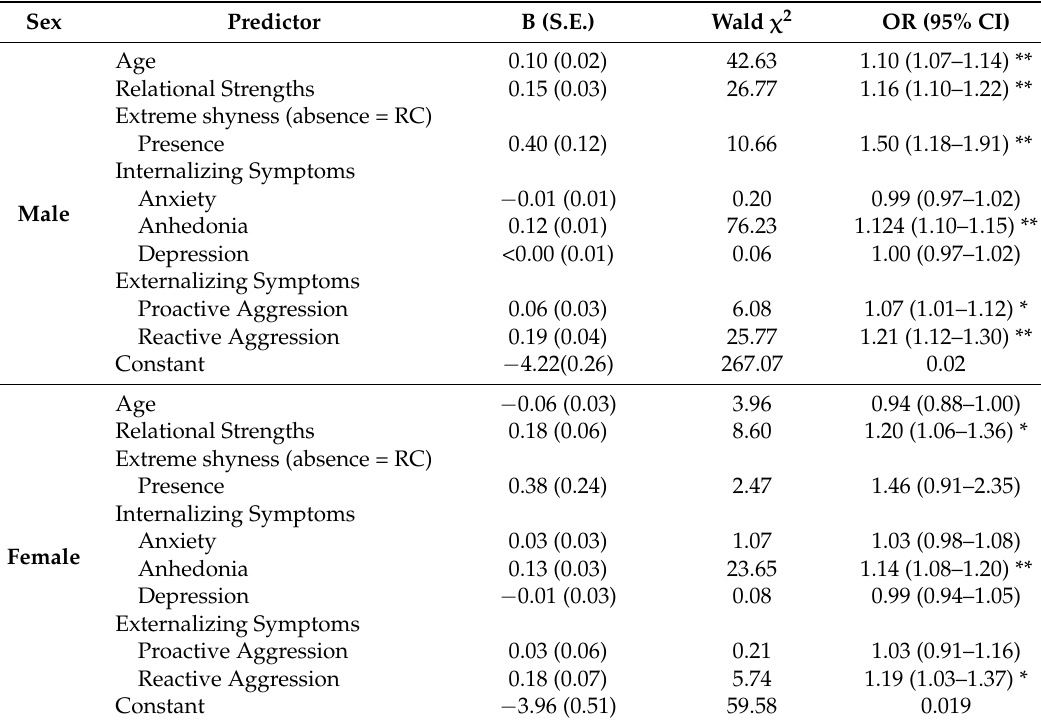
Table 4. Regression analysis: Problematic Video gaming as the dependent variable and facets of internalizing and externalizing symptoms as predictors split by